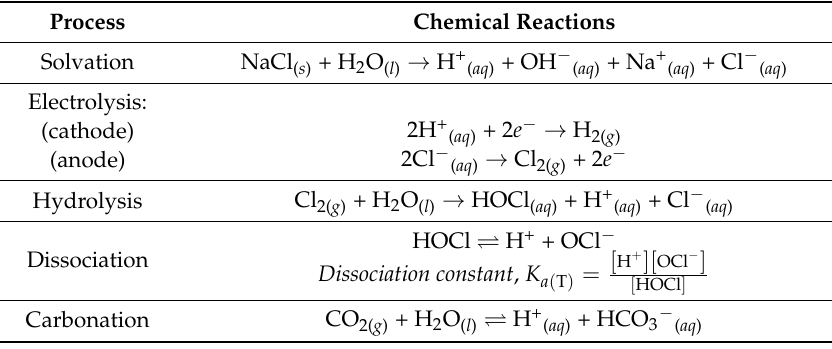
Table 2. Electrolytic disinfection chemical process